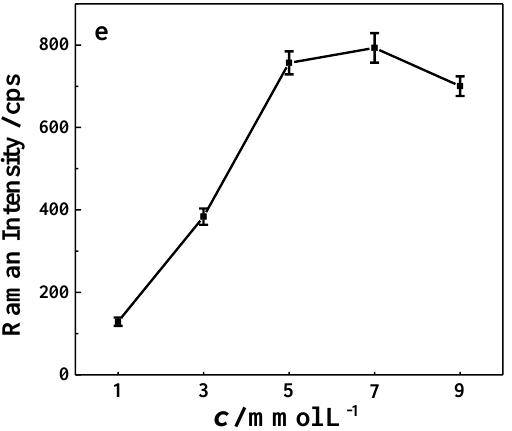
Figure 4. SERS intensity change of SH at 1594 cm −1 using β-CD-Ag/PVA with different densities of β-CD-Ag NPs (from 1 to 9 mmol · L −1 ).